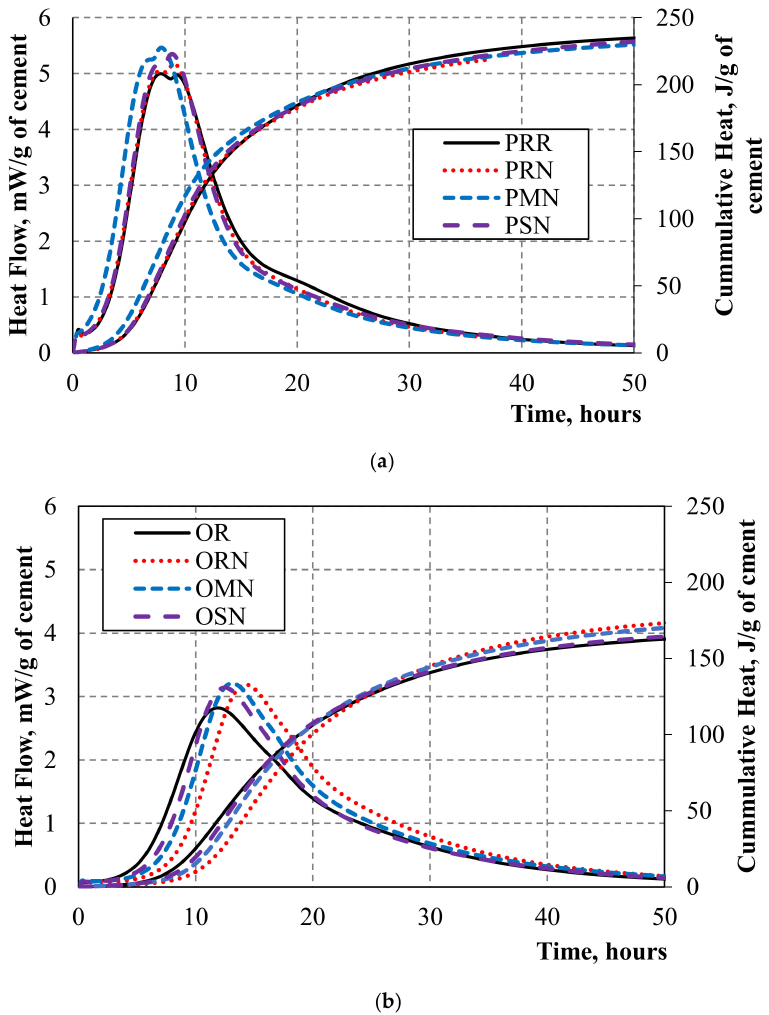
Figure 3. Heat of hydration of mortars with ( a ) Type I Portland cement and ( b ) Type V